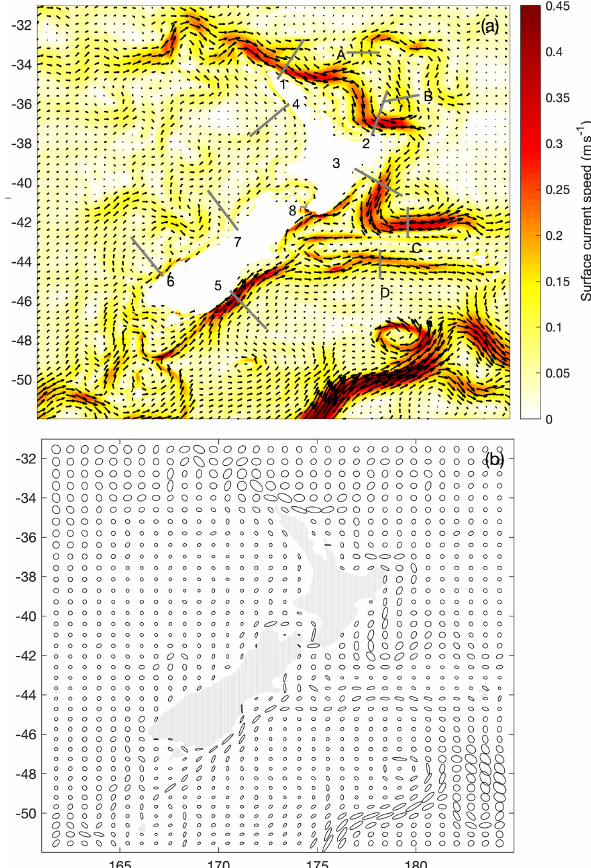
Figure 10. Mean surface current speed and velocity vectors (a) and velocity variance ellipses (b) . Data are from the daily-averaged out- put from the 25-year Moana Ocean Hindcast (also known as Moana Backbone). Sections for the transport calculations are